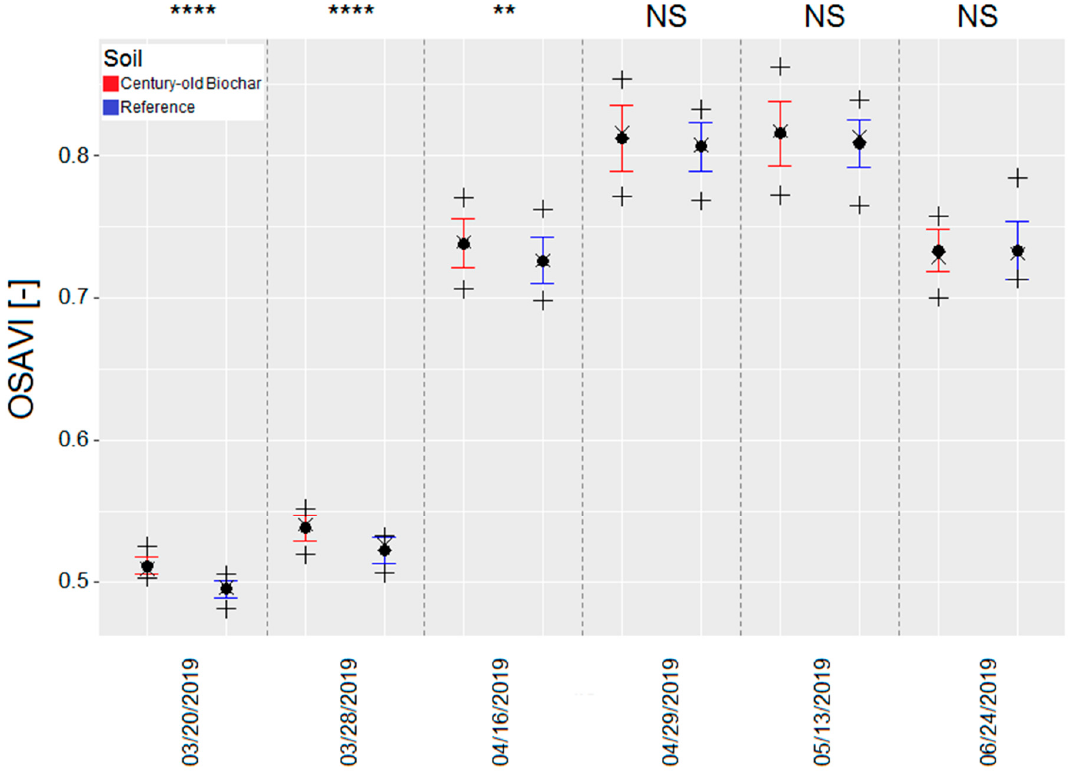
Figure 7. Comparison of the optimized soil adjusted vegetation index (OSAVI) of all of the 11 century-old biochar plots (red) versus the 11 reference plots for each acquisition date. The black circle and cross represent the mean and median OSAVI, respectively. The error-bar represents the corresponding standard deviation. The bottom and top black pluses (+) indicate the minimum and maximum OSAVI, respectively. Outside of the plot, asterisks *, **, ***, and **** reveal the statistical levels of significance and the acronym NS stands for non-significant.